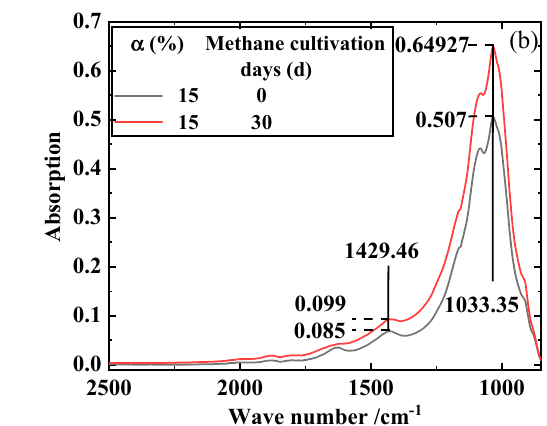
Figure 16. SEM images of the biochar–clay mixture under different biochar contents: ( a ) α = 10%; ( b ) α = 15%.